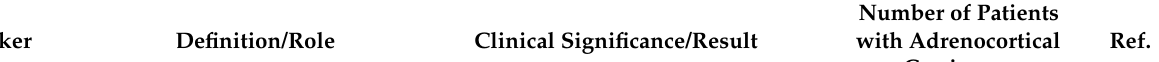
Table 2. Review of novel immunohistochemically analyzed markers of adrenocortical carcinoma.